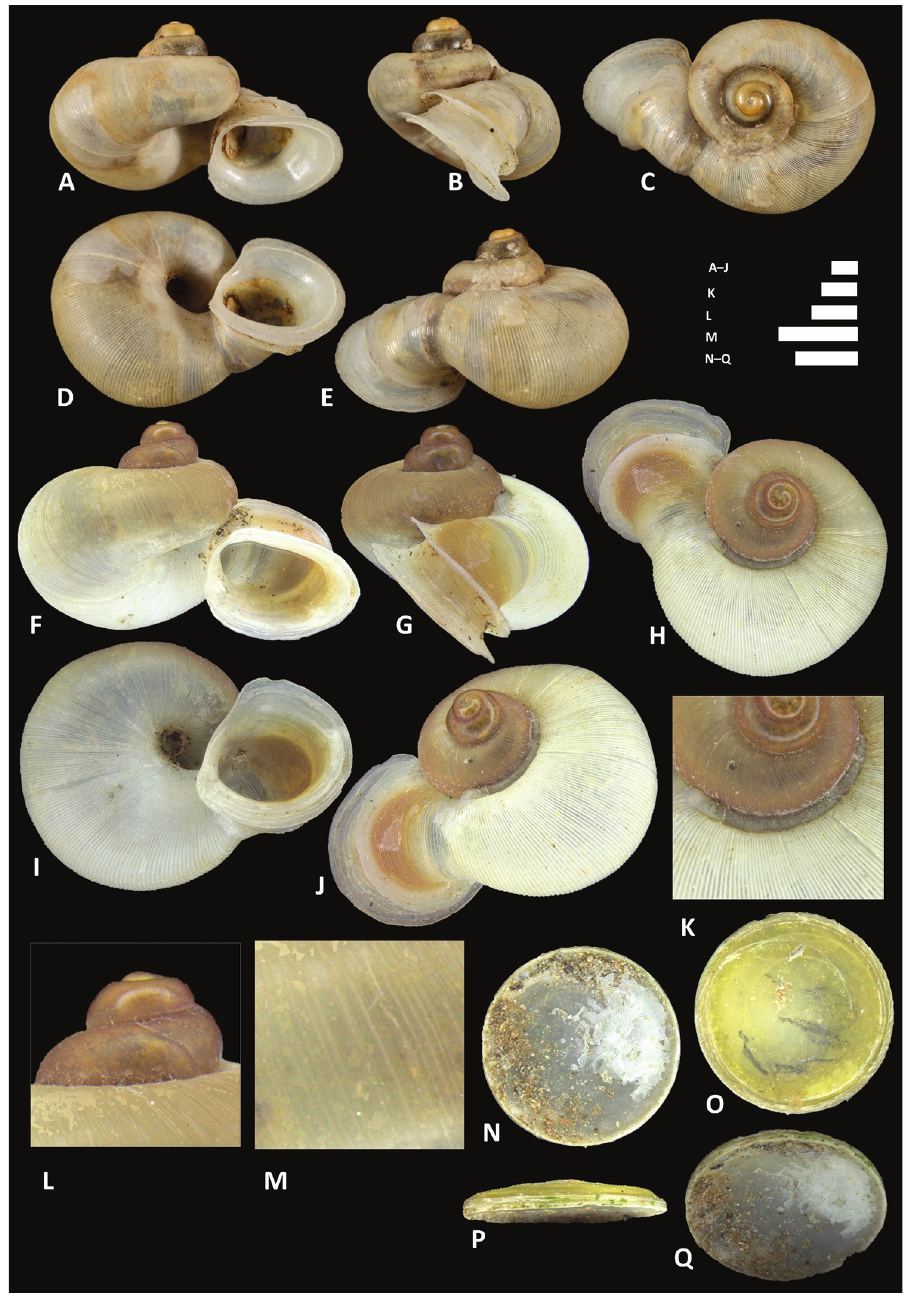
Figure 19. Alycaeus jousseaumei Morgan, 1885a. A–E Shell of syntype, MNHN-IM-2000-31801 F–J Shell of BOR/MOL 11211 K–M Close up of shell of BOR/MOL 11211 N–Q Operculum of BOR/ MOL 11211. Scale bars: A–Q 1 mm. Photographs A–E by Manuel Caballer (reproduced herein under CC-BY 4.0 license, Project RECOLNAT, MNHN). Photographs F–V by Junn Kitt